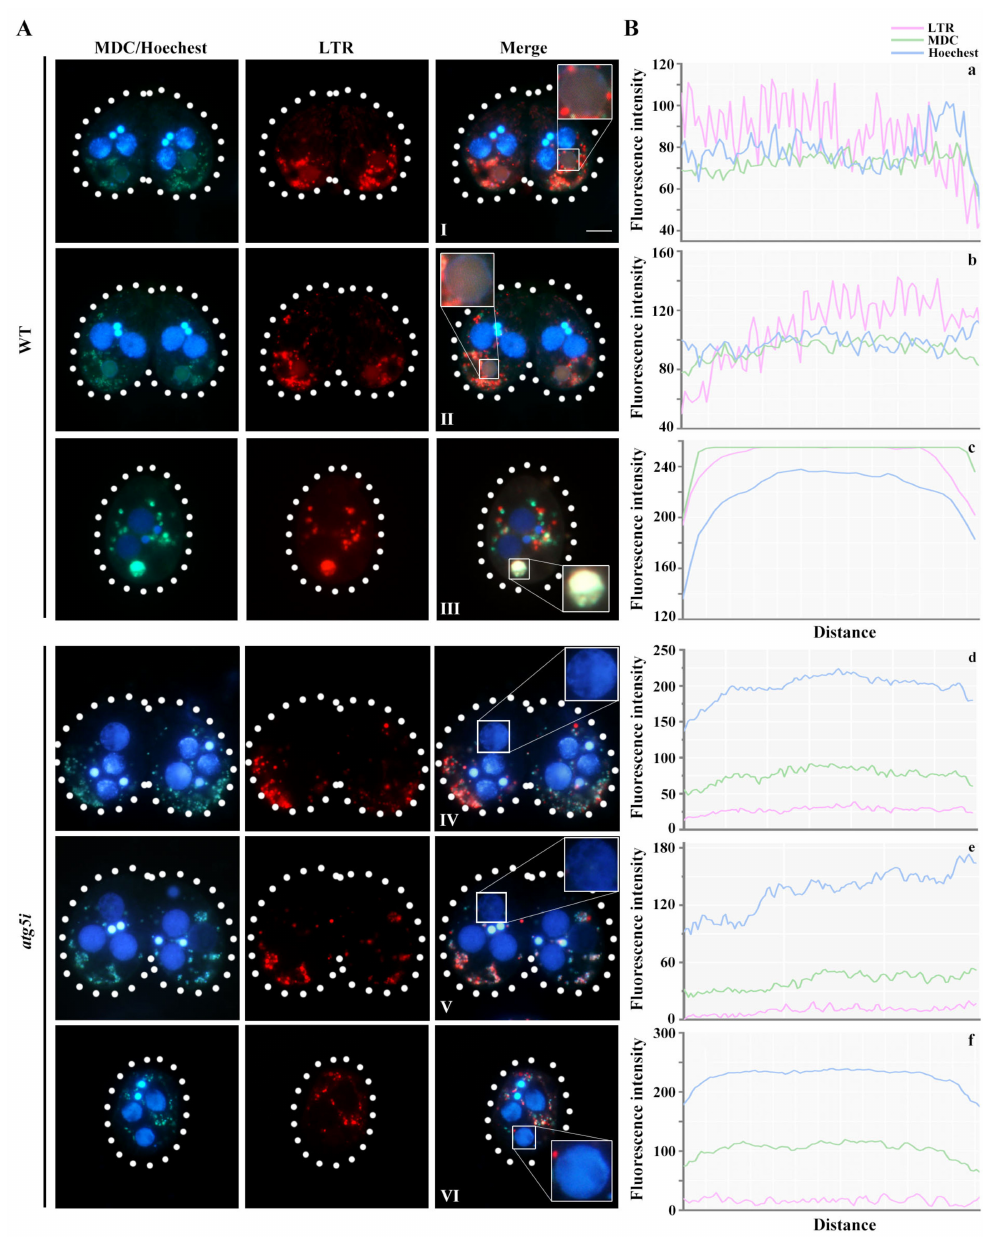
Figure 4. paMAC failed to acidify during PND in atg5i mutants. ( A ): Conjugating cells at 8 (I,IV), 10 (II,V), and 12 h (III,VI) were stained with MDC, LTR, and Hoechest in WT and atg5i cell lines. Dashed circle represents the cell outline of Tetrahymena . Scale, 20 µ m; ( B ): The fluorescence intensities of the three probes were analyzed in the region of the selected nucleus (white box) in the merged diagram (left panel) with Image J (version:1.8.0, National Institutes of Health, Bethesda, MD, USA), corresponding to the